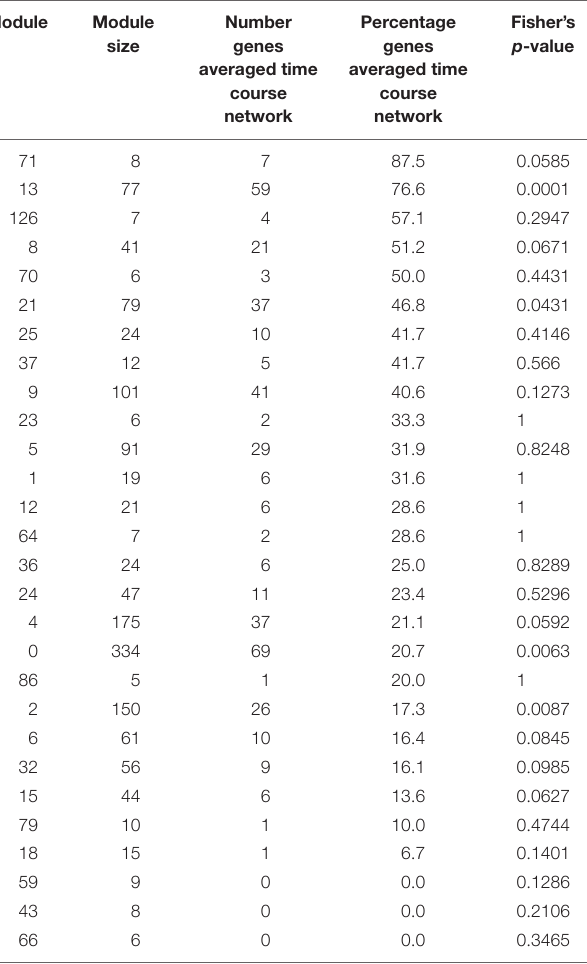
TABLE 1 | Number and percentage of HVGs in each module, for modules with at least five genes. Module